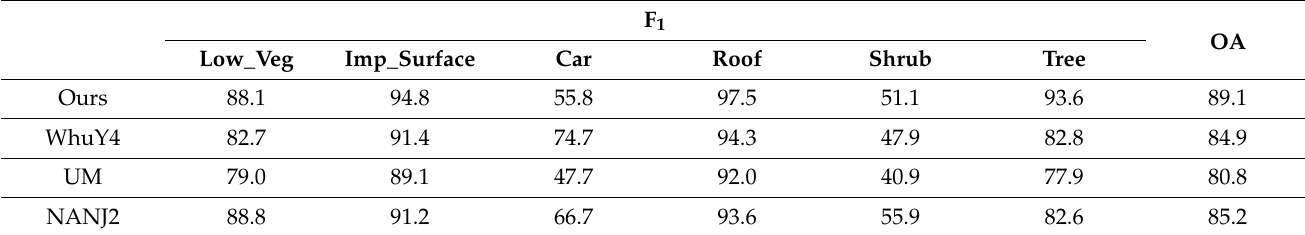
Table 6. Vaihingen City datasets for each class of IoU (%).